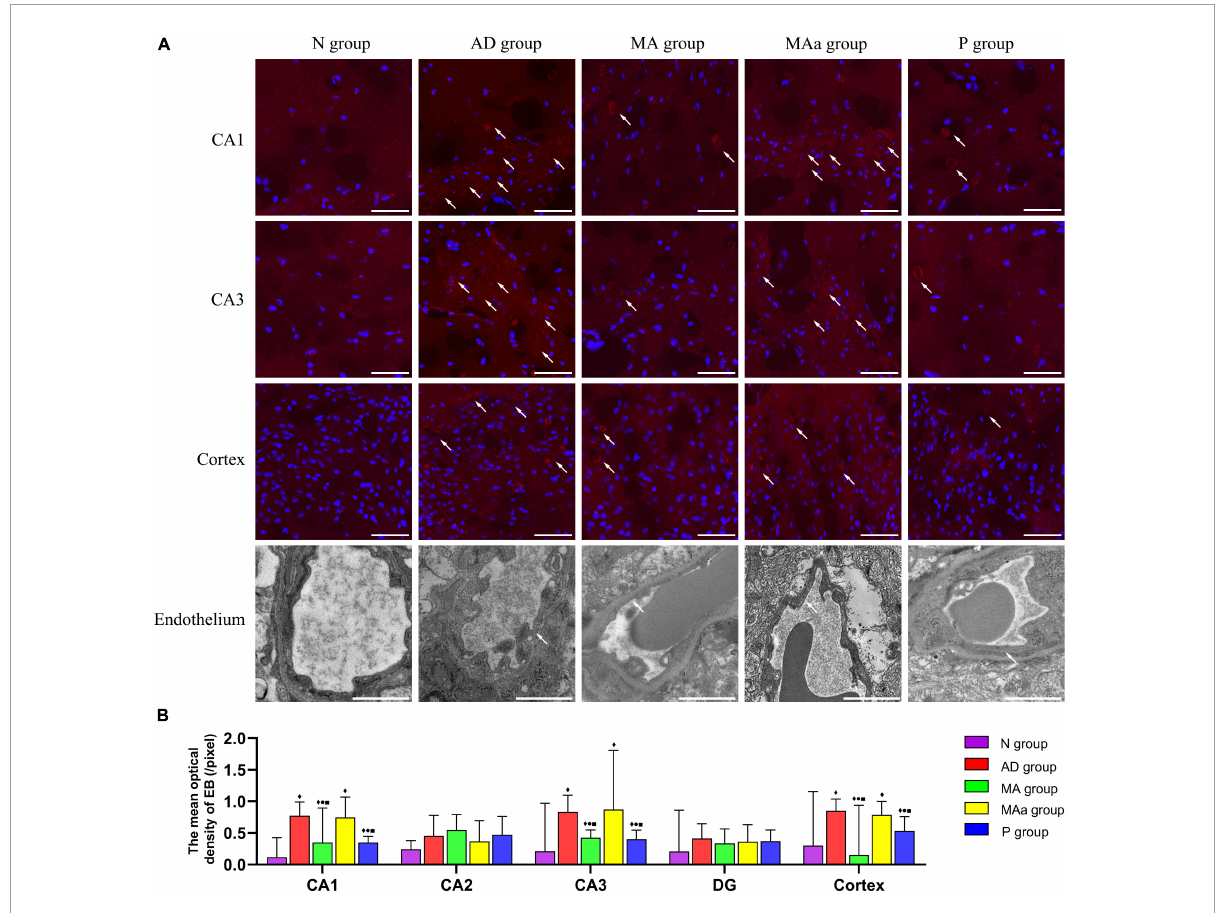
FIGURE3 Results of EB extravasation and TEM analysis for each group ( n = 6, mean ± SD). (A) Representative images of EB exudation and endothelial structure in each group (CA1, CA3, and cortex). Representative images of EB exudation in the CA2 and DG regions are shown in the Supplementary material . EB is labeled with red fluorescence. The nucleus is labeled with blue fluorescence. Scale bar is 20 µ m. For endothelial structures, scale bar is 1 µ m. (B) Comparison of the mean optical density in each group (CA1, CA2, CA3, DG, and cortex). Compared to the N group, (cid:7) p < 0.01 or p < 0.05. Compared to the AD group, • p < 0.01 or p < 0.05. Compared to the MAa group, (cid:4) p < 0.01 or p <